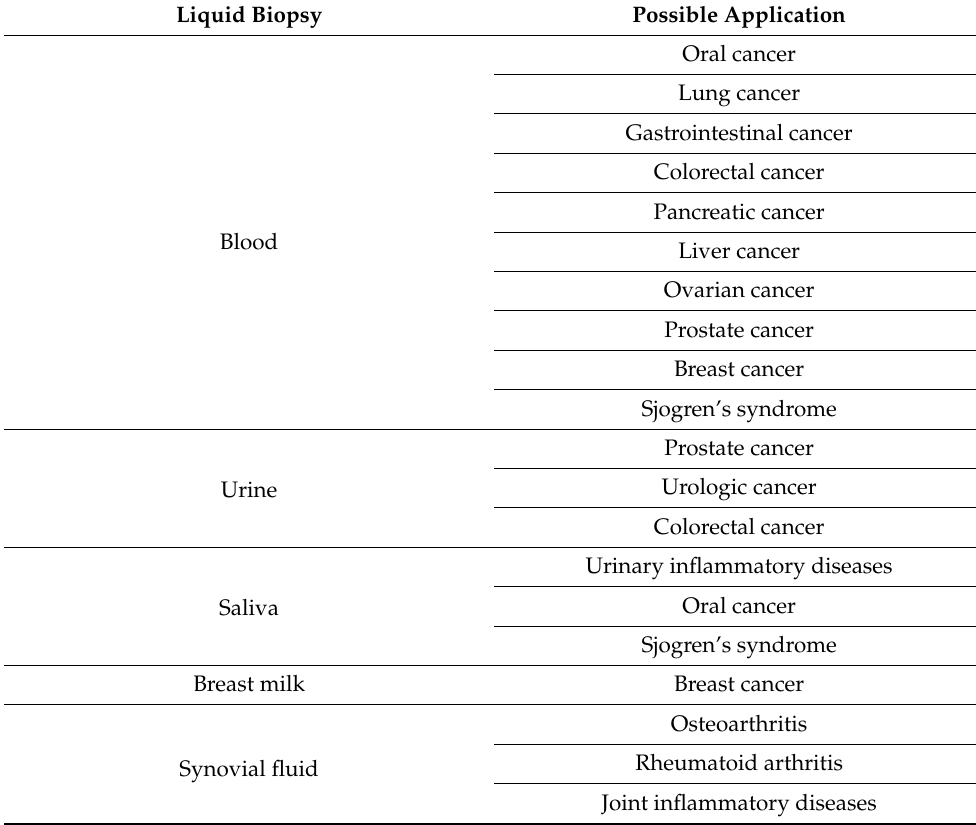
Table 1. Summary table representing the main uses of different liquid